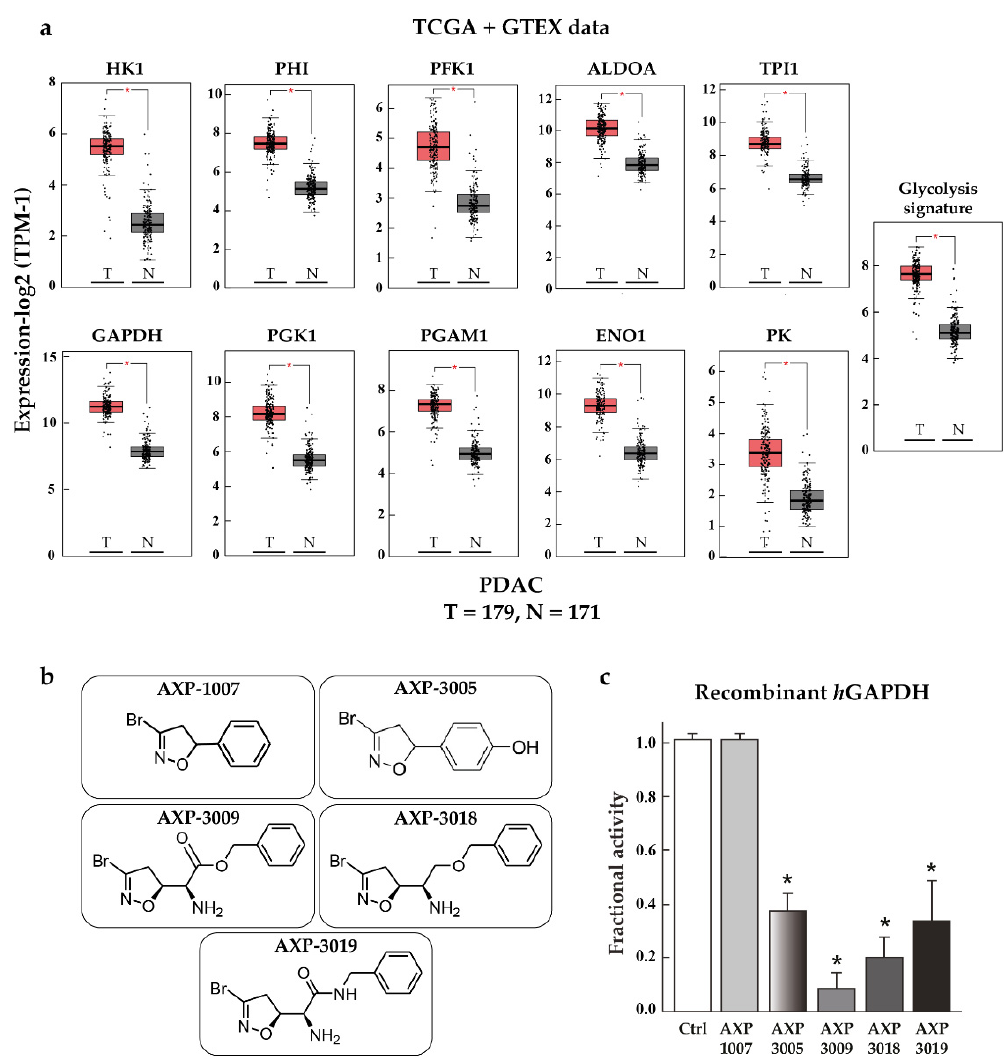
Figure 1. TCGA + GTEX data and h GAPDH activity. ( a ) Relative mRNA expression of genes regulating glycolysis pathway for normal human pancreas (N) and PDAC tissues (T), using TCGA and GTEx dataset (webtool GAPIA2). ( b ) Structures of the GAPDH inhibitors tested in this study. ( c ) Recombinant h GAPDH fractional activity upon incubation for 48 h at 37 ◦ C with GAPDH inhibitors at 10 µ M concentration. Statistical analysis * p < 0.05 .